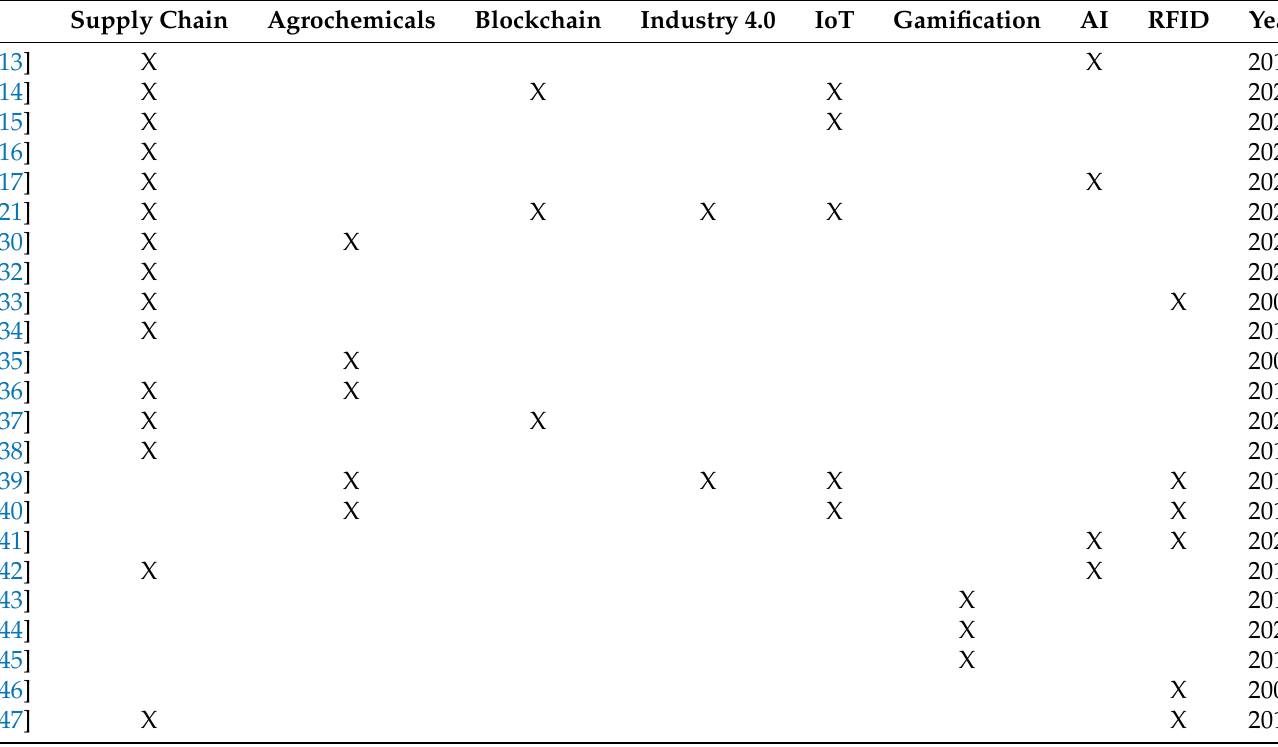
Table 1. Related works and main domain